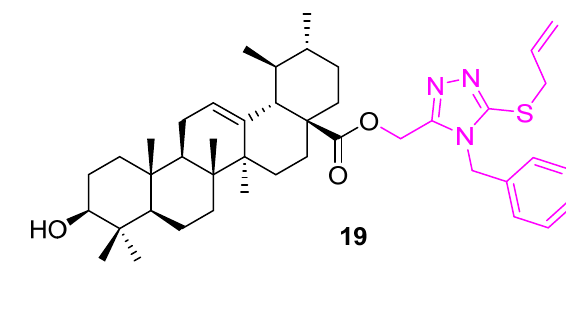
Figure 13. Structure of 18 , 19 .